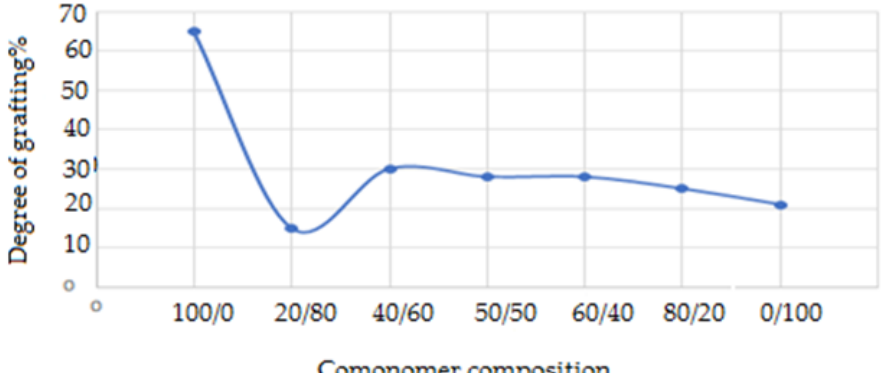
Figure 3. Effect of the comonomer composition on the degree of grafting on the polypropylene at an inhibitor concentration of 2.5 gm FeCl 3 by wt%, at a comonomer concentration of 60 wt%, and a solvent concentration of 70% methanol and 30% H 2 O, irradiated at 20 KGy in a nitrogen system.